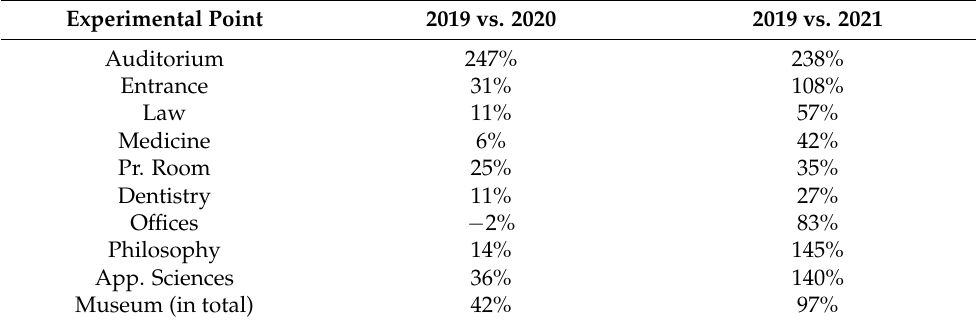
Table 3. Percentages of differences for TVOC levels within the museum compared to